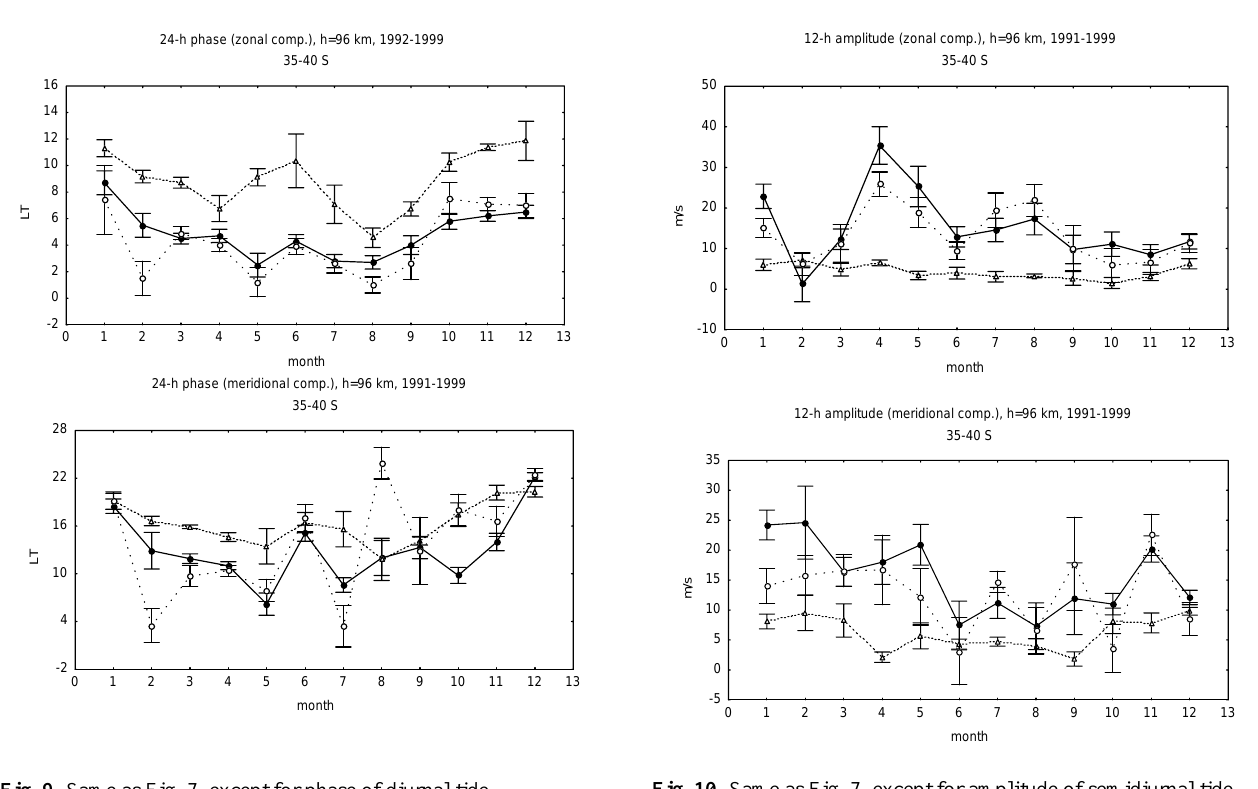
Fig. 9. Same as Fig. 7, except for phase of diurnal tide. Fig. 10. Same as Fig. 7, except for amplitude of semidiurnal tide.